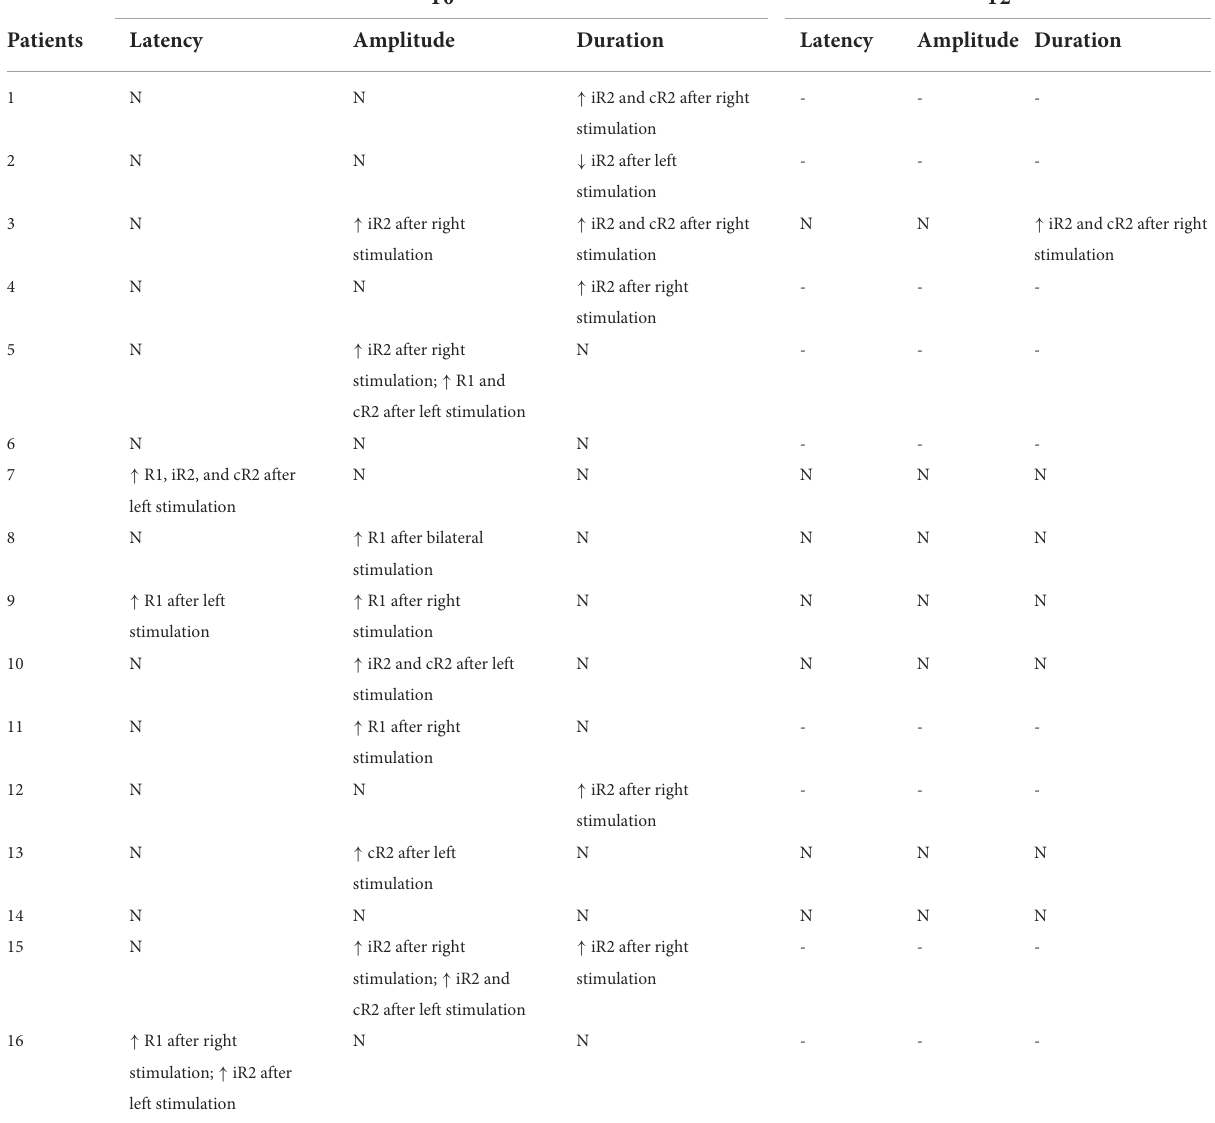
TABLE 5 Individual parameters of the blink reflex in COVID-19 patients as compared to healthy subjects at baseline and at 20-month follow-up. T0 T2 Patients Latency Amplitude Duration